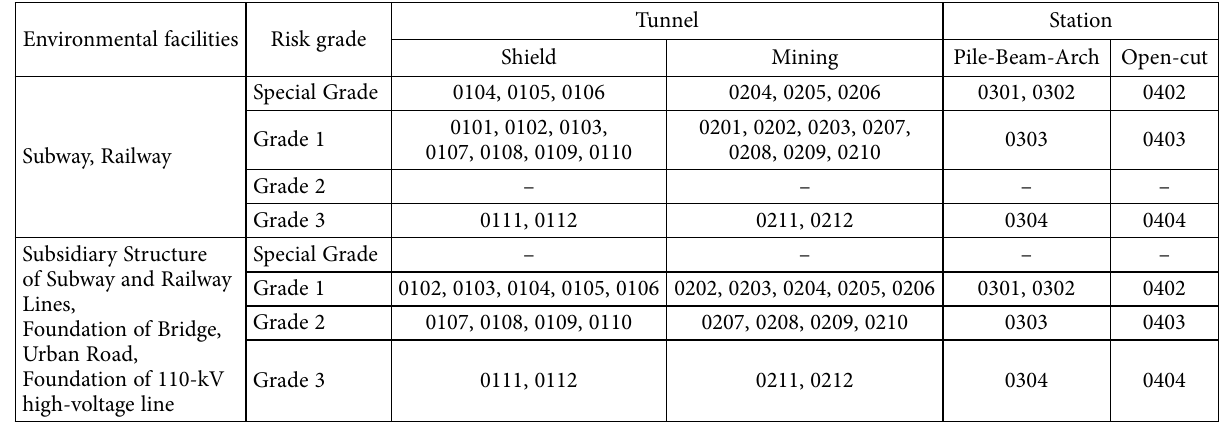
Table 4. Part of the discriminant rule base for environmental risk Environmental facilities